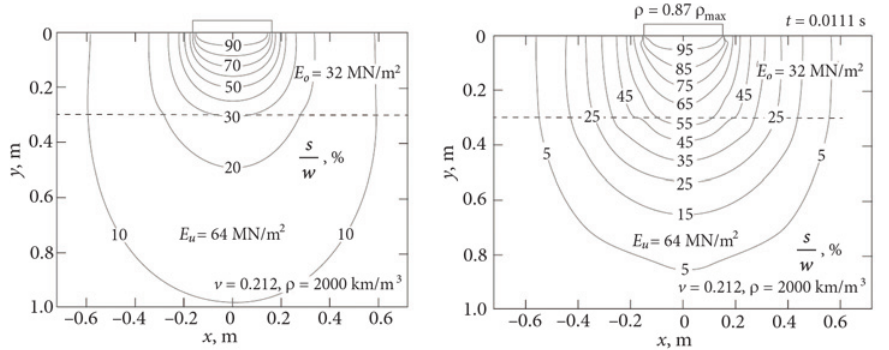
fig. 5. Comparison of static (left) and dynamic (right) tests range (Adam et al.